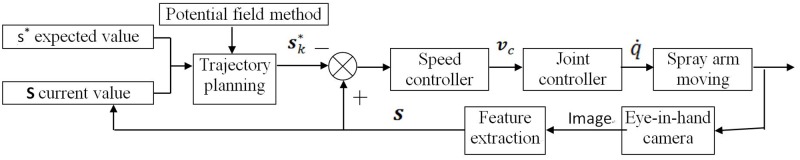
Block diagram of the proposed visual control system.